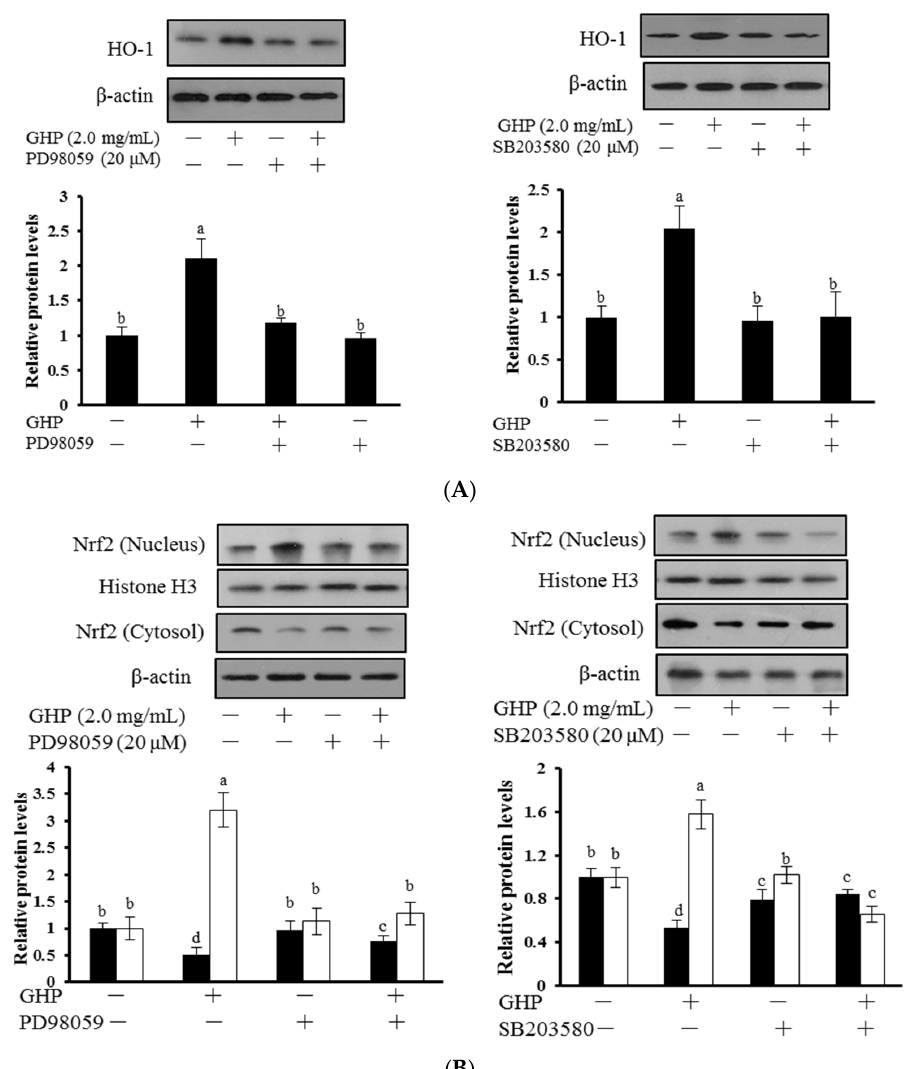
Figure 5. Roles of ERK1/2 and p38 MAPK in GHP ‐ induced Nrf2 activation and HO ‐ 1 expression in HepG2 cells. ( A ) Cells were pretreated with PD98059 (20 μ M) or SB203580 (20 μ M) for 2 h prior to incubation with GHP (2.0 mg/mL) for 12 h. Cells were harvested and HO ‐ 1 expression was determined by Western blot analysis; ( B ) Cells were pretreated with either PD98059 or SB203580, each at a concentration of 20 μ M, for 2 h prior to incubation with GHP (2.0 mg/mL) for additional 12 h. Then nuclear and cytosol levels of Nrf2 were measured by Western blot analysis. The results are presented as the means ± SD of three independent experiments. Means with different letters are significantly different from each other at p < 0.05.